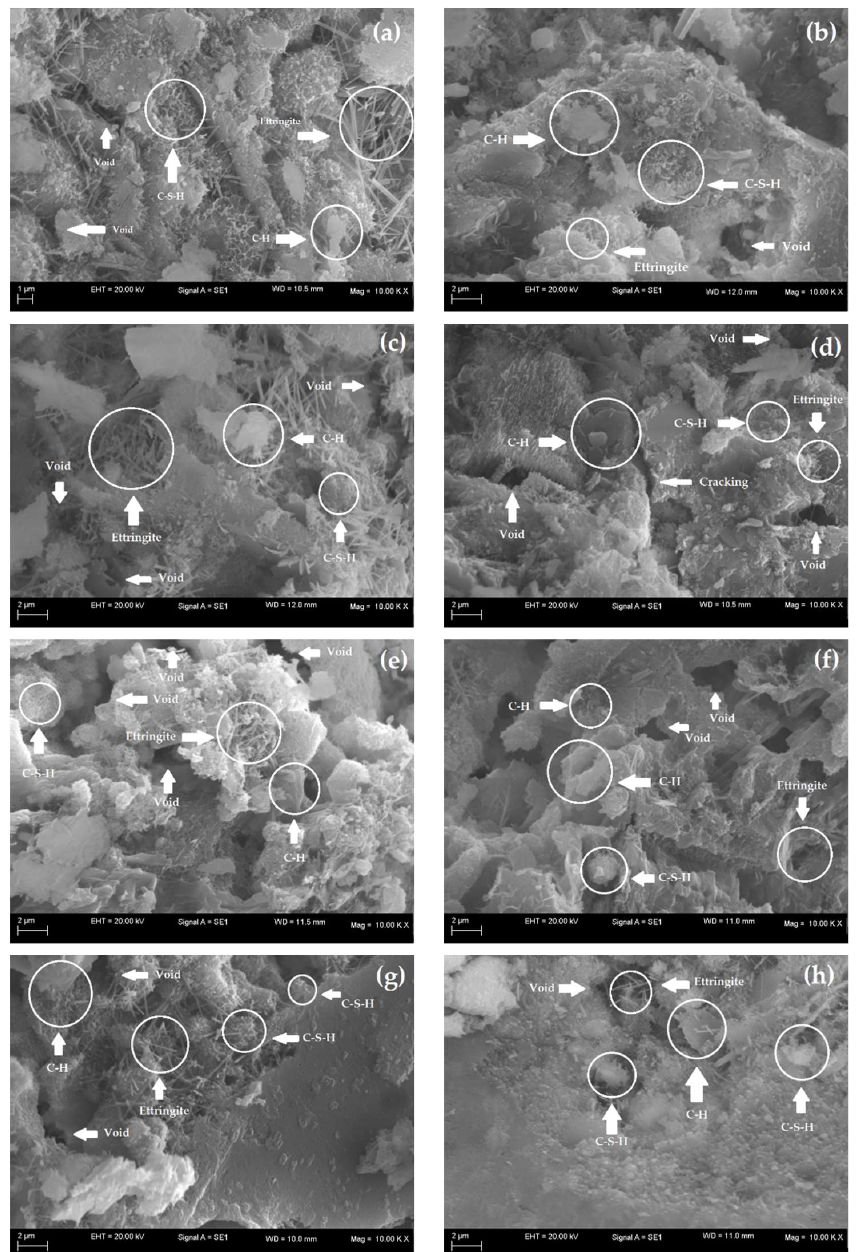
Figure 9. SEM images of the cement mortars ( a ) M (control) at 7 d, ( b ) M (control) at 28 d, ( c ) M0 at 7 d, ( d ) M0 at 28 d, ( e ) M10 at 7 d, ( f ) M10 at 28 d, ( g ) M20 at 7 d and ( h ) M20 at 28